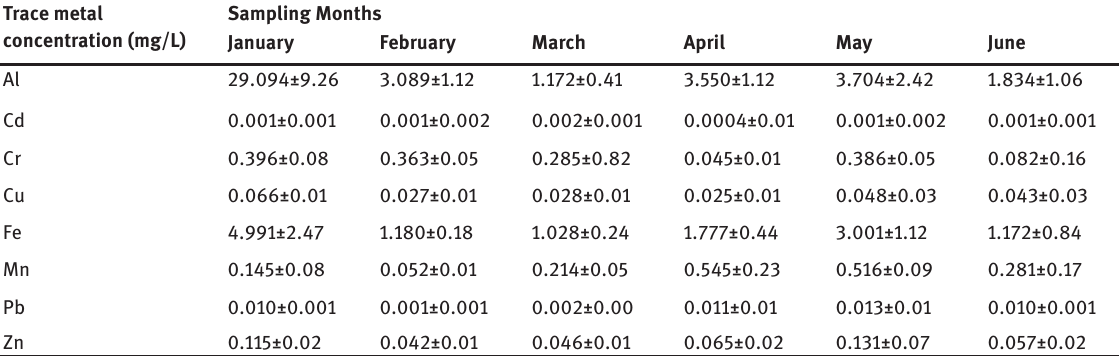
Table 1: Average level of trace metal in Nzhelele River